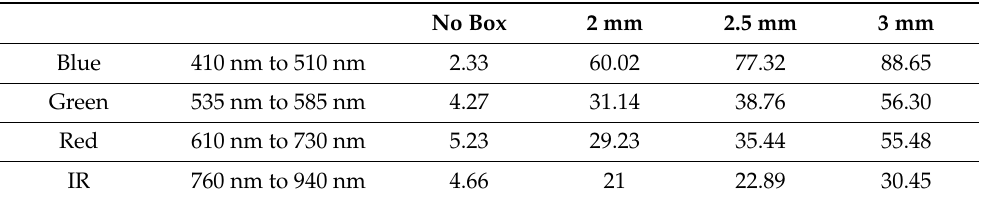
Table 3. Comparison of the means of raw spectral intensity for each color group of the AS7265x. The 18 spectral channels were grouped by five colors, and the average is shown below. The 2 mm box was the closest to the raw sensor